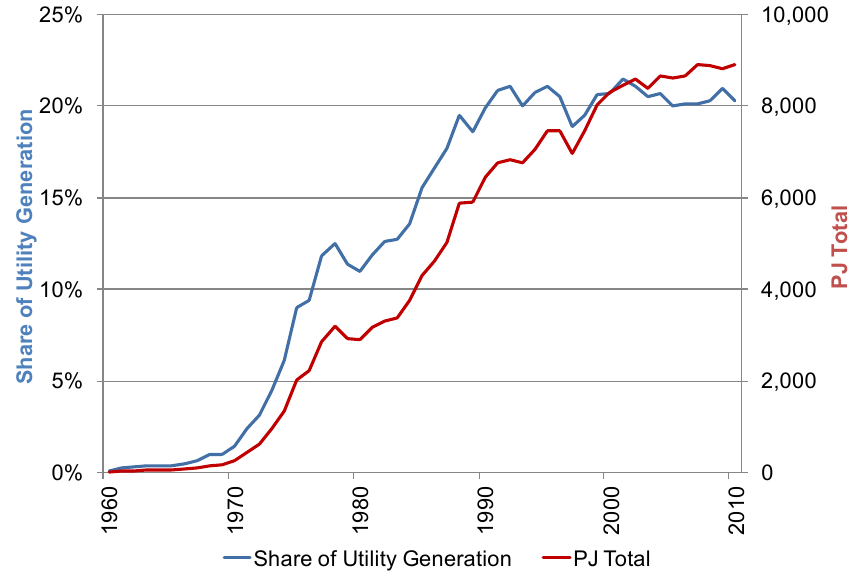
Figure 11. U.S. nuclear energy consumption, 1960–2010. Source: